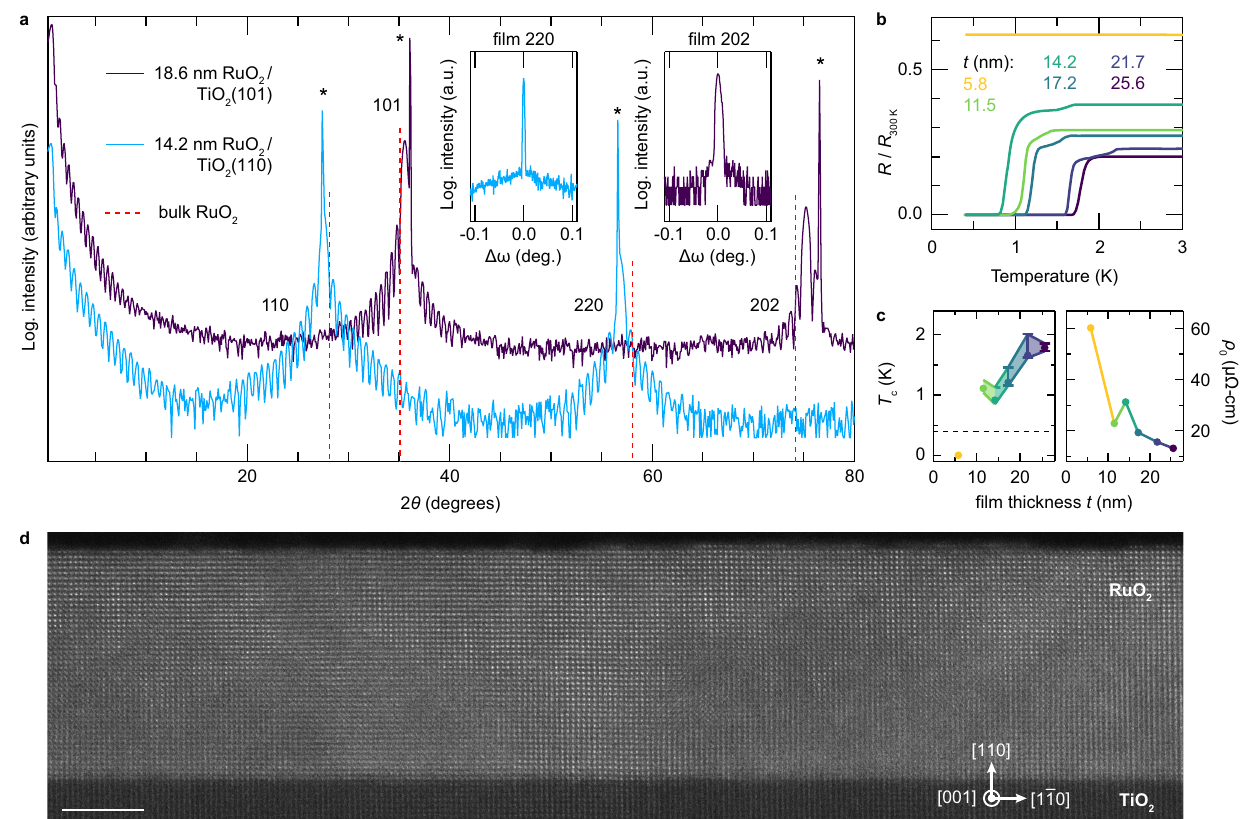
Fig. 2 Structural characterization of epitaxially strained RuO 2 thin fi lms, and fi lm-thickness-dependent superconductivity for RuO 2 (110). a XRD data acquired with Cu-K α radiation along the specular crystal truncation rods for 18.6nm thick RuO 2 (101) and 14.2nm thick RuO 2 (110) fi lms. Bragg peaks arising from the TiO 2 substrates are marked with asterisks, and the peak positions that would be expected for unstrained bulk RuO 2 are indicated by dashed red lines 13 . Insets display rocking curves with FWHMs < 0.01° acquired at the 2 θ values corresponding to the primary 220 and 202 fi lm peaks. Here q ∣∣ is aligned with TiO 2 ½ 110 (cid:2) for the (110)-oriented sample, and with TiO 2 ½ 101 (cid:2) for the (101)-oriented sample. b Resistance versus temperature curves for RuO 2 (110) samples with different fi lm thicknesses t , normalized to their values at 300 K. c Superconducting T c s and residual resistivities ρ 0 plotted versus fi lm thickness for the RuO 2 (110) samples from ( b ). Error bars on T c s have the same meaning as in Fig. 1. The horizontal dashed line represents the base temperature attainable in our refrigerator, 0.4 K. d STEM image of the same 14.2nm thick RuO 2 (110) sample from ( a – c ) (scale bar = 5nm). More comprehensive structural and electrical characterization of the samples shown here are included in Supplementary Notes 3, 4 and Supplementary Figs. 3 – plot energy versus momentum spectra acquired along the white dashed lines in Fig. 3d: in Fig. 3e, the spectrum is dominated by the fl at d ∣∣ bands centered around a binding energy of 300 meV, whereas in Fig. 3f the ( d xz , d yz )-derived bands are steeply dispersing and can be tracked down to several hundred meV below E F , both of which are well reproduced by DFT + U calculations. The reasonable agreement between the experimen- tally measured and DFT band velocities is consistent with recent ARPES studies of Ir-doped RuO 2 single crystals 33 and with earlier